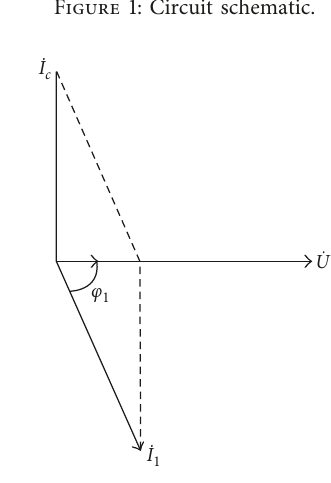
Figure 2: Vector